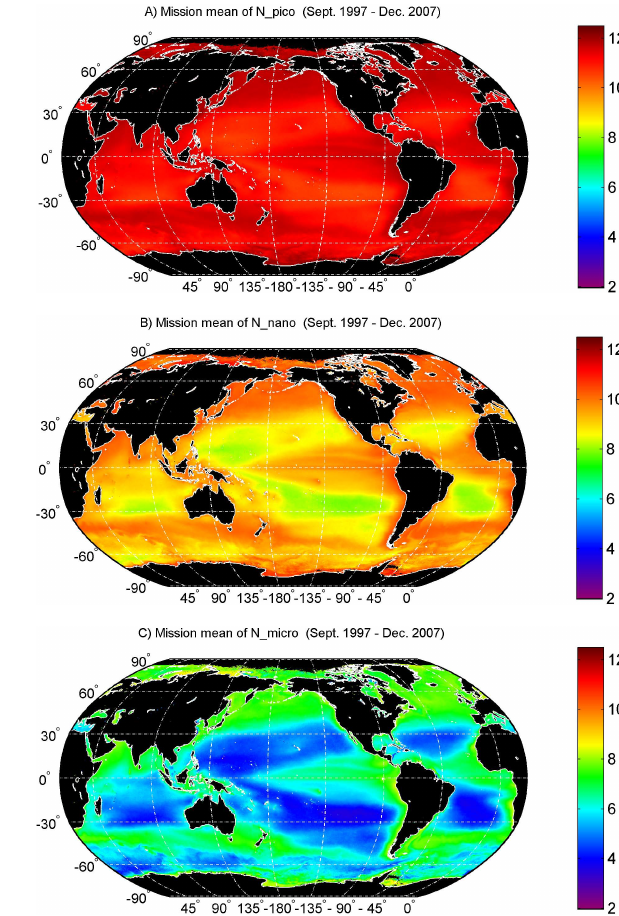
Fig. 4. (A) Mean global SST ( ◦ C) (Sep 1997–Dec 2007) based on monthly AVHRR Pathfinder v 5.0 data; (B) SeaWiFS mission mean of chlorophyll-a concentration in mgm − 3 (log10 color scale), and (C) SeaWiFS mission mean of the PSD slope, ξ , (unitless) as derived by the Kostadinov et al. (2009) algorithm.